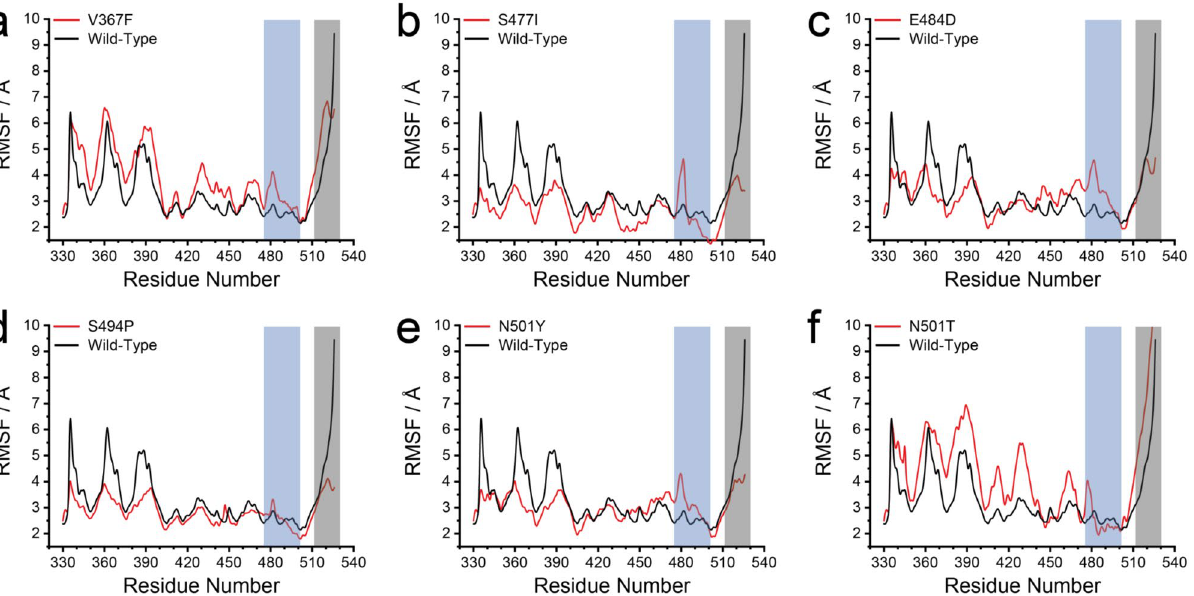
Figure 3. Structural dynamics of RBD mutations on the binding affinity. The root-mean-square fluctuations (RMSF) of spike RBD-ACE2 binding complex; ( a ) V367F, ( b ) S477I, ( c ) E484D, ( d ) S494P, ( e ) N501Y, and ( f ) N501T, in comparison to the wild-type. The RBD interface residues are highlighted in cyan (residues 475–500) and gray (residues 515–525)